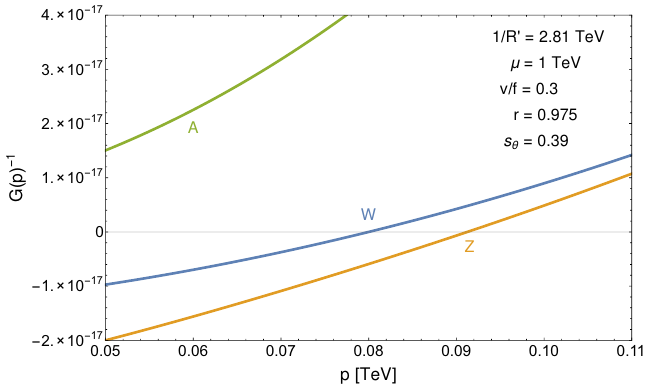
Figure 10 . Inverse Green’s function for the gauge bosons for v=f = 0 : 3. The zero modes are at m W and m Z